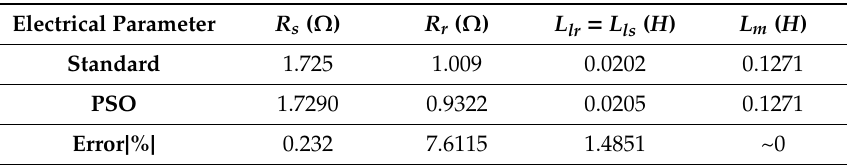
Table 1. Estimated and Standard Induction Motor Parameters.